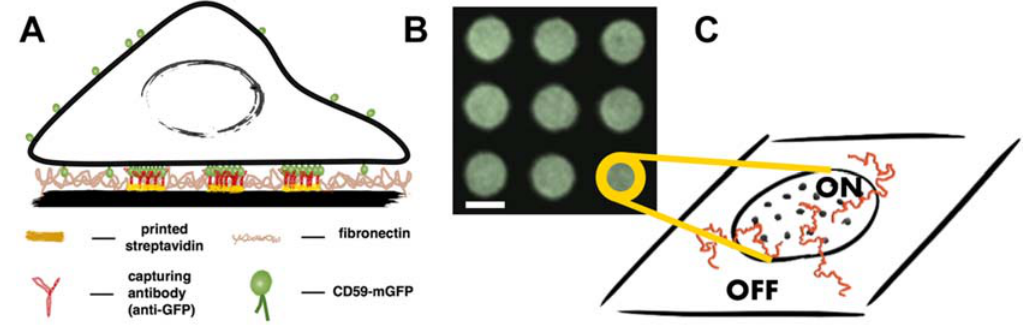
Figure 1. Principle of the experimental design and data analysis. ( A ) Antibody patterns are used to enrich and immobilize CD59-monomeric green fluorescent protein (mGFP) at specific sites in the plasma membrane of living T24 cells. Cells are interfaced with microstructured surfaces containing different densities of antibody, so that different surface densities of immobilized CD59-mGFP can be adjusted; ( B ) Typical region of interest in a micropatterned cell showing enrichment of CD59-mGFP in “ON” areas and depletion in “OFF” areas. Scale bar is 3 µ m; ( C ) Sketch depicting individual immobilized CD59-mGFP molecules (dots) in “ON” areas. Trajectories of fluorescently labeled lipids (shown in red) are recorded and separated into the categories “ON” and “OFF” according to the CD59-mGFP patterns recorded in the GFP color channel.